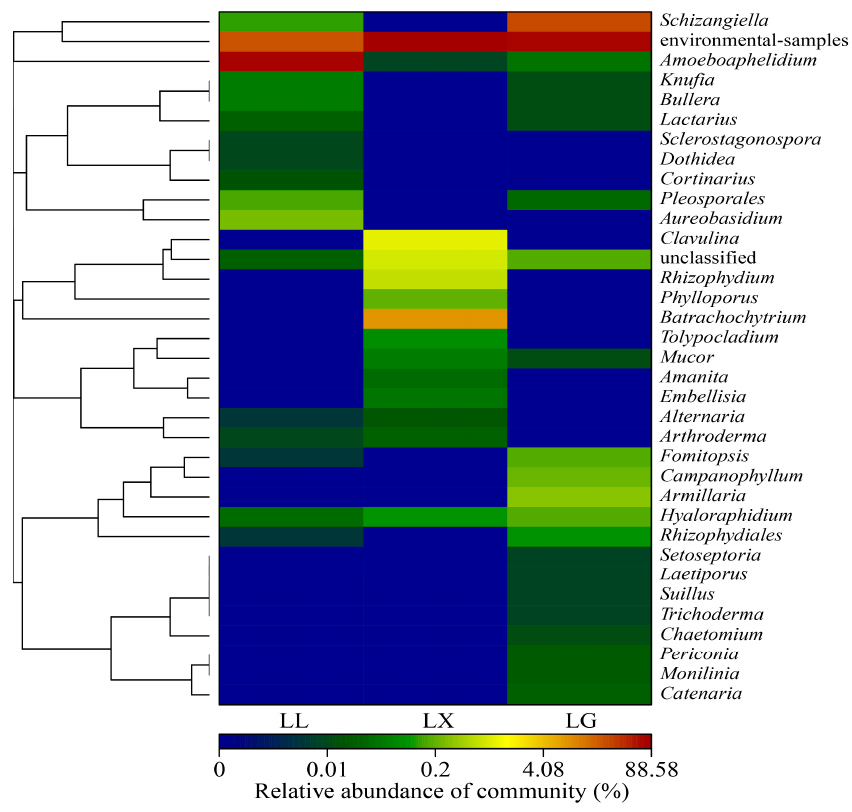
Figure 6. Heat map profile showing 35 representative predominant ITS gene sequence data based on classified at the genus level using the UNITE (http://unite.ut.ee) classifier database. LX, LG and LL represent Xingqing lake, Geming lake and Lianhu lake, respectively.